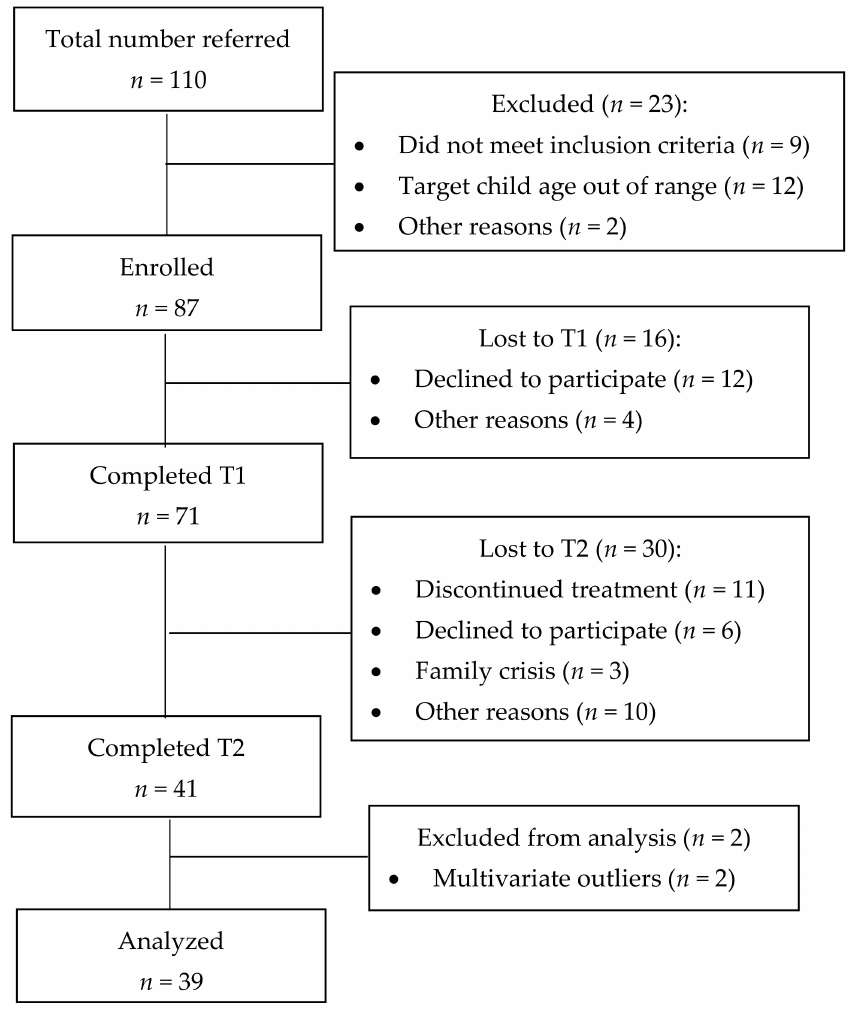
Figure 1. Flowchart of participants through the